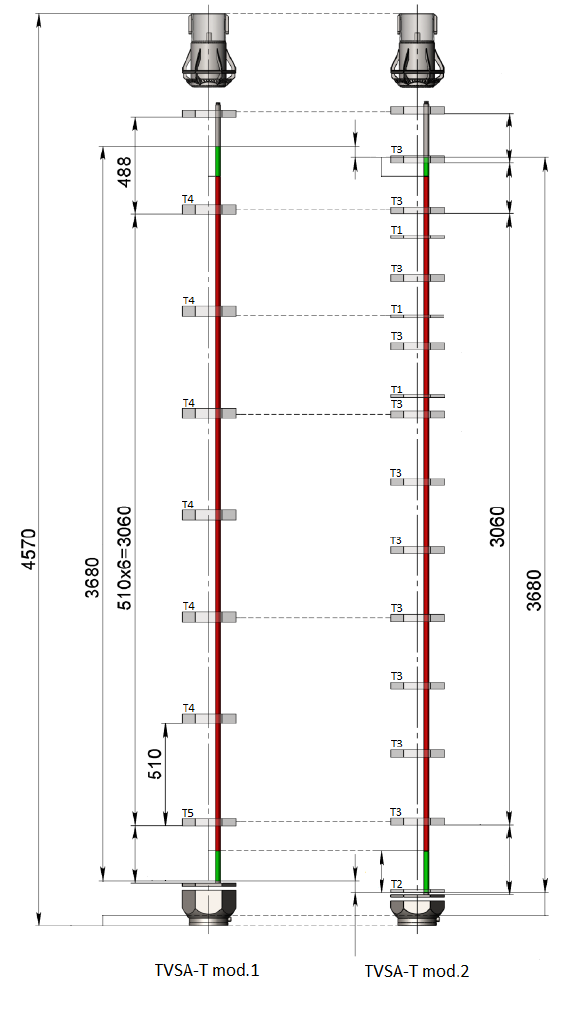
Figure 4. Axial geometry of TVSA-T mod.1/2.